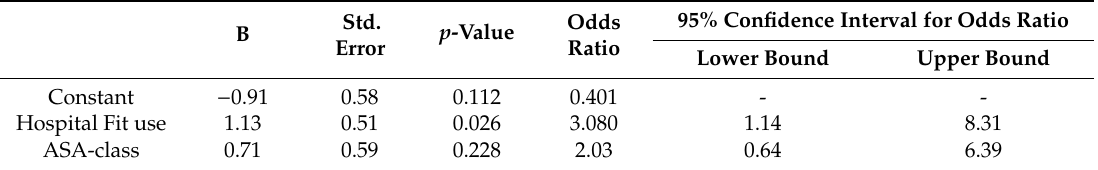
Table 5. Multiple logistic regression analysis—the association between the achievement of functional recovery on POD1 and Hospital Fit use, corrected for ASA-class. B